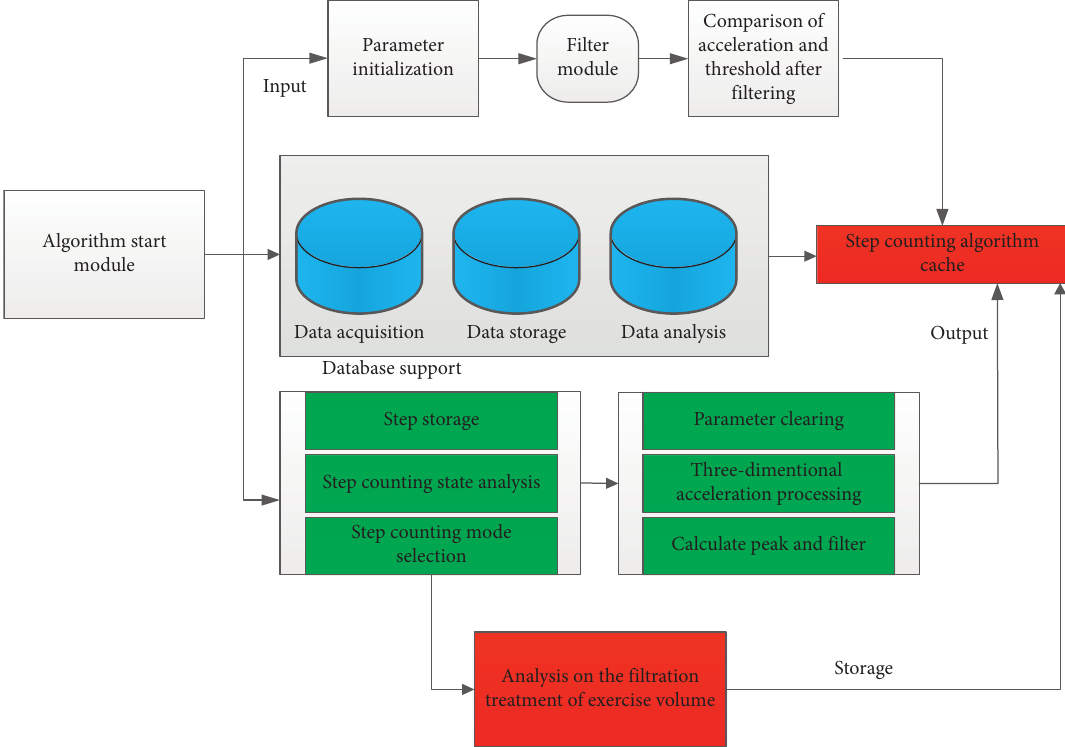
Figure 1: Running framework of step counting algorithm in intelligent wearable